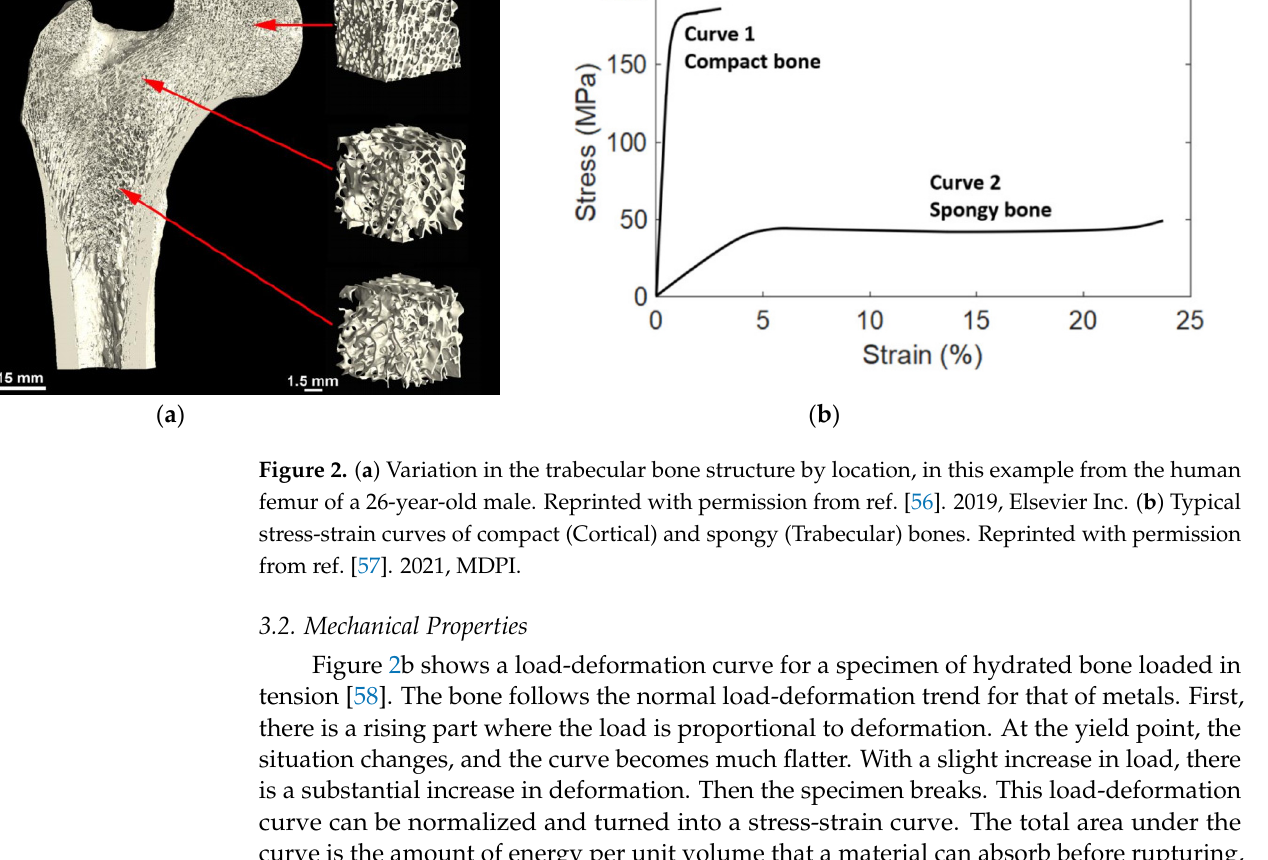
Figure 1. Structural levels of bone from macro to subnanometer scale. Reprinted with permission from ref. [17]. 2016, Elsevier Ltd.